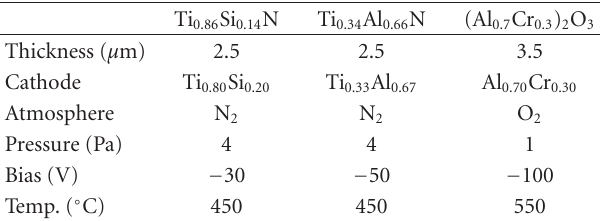
Table 1: Deposition process parameters and thickness for the coatings investigated.